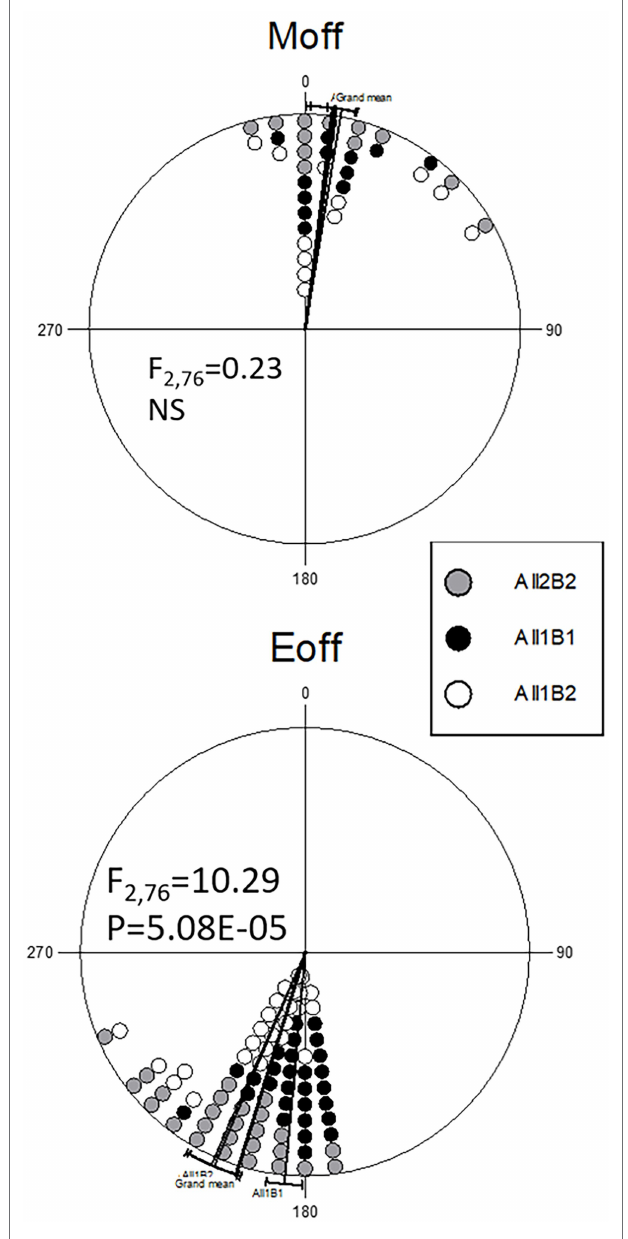
FIGURE 7 | Circadian phase in transgenic flies carrying different cry haplotypes. Phase distributions of the morning ( top ) and evening ( bottom ) locomotor activity bouts are shown (offset). The sector 0 ° –180 ° represents the light phase (Zt 0–12), while dark is between 181 ° and 360 ° (Zt 12–24). Each symbol represents 1–3 observations. The circular statistics Watson- Williams F -test is also shown. 15 ° = 1 h. ( Supplementary Figure S3 ). Interestingly, the phase differences were not due to a difference in the FRP, which did not differ between the haplotypes ( F 2,93 = 0.22, p = 0.81;